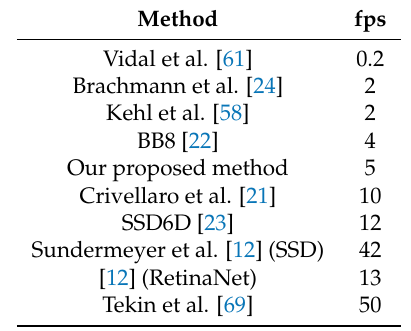
Table 4. Performance time for single object pose